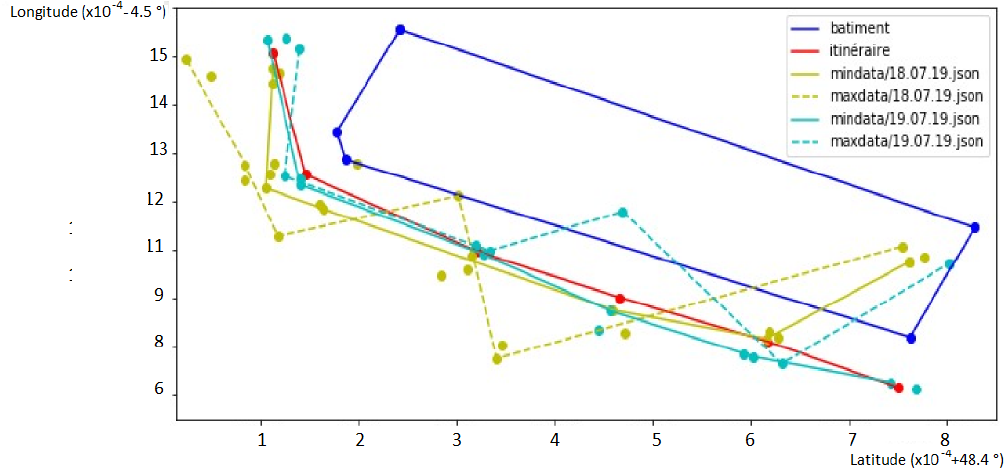
Figure 27. Accuracy comparison between the reference path and the learned